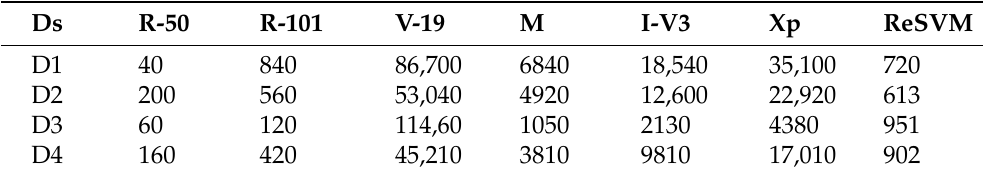
Table 4. Comparison of proposed approach i.e., ReSVM, in terms of time with existing architectures on four datasets. T(s) =